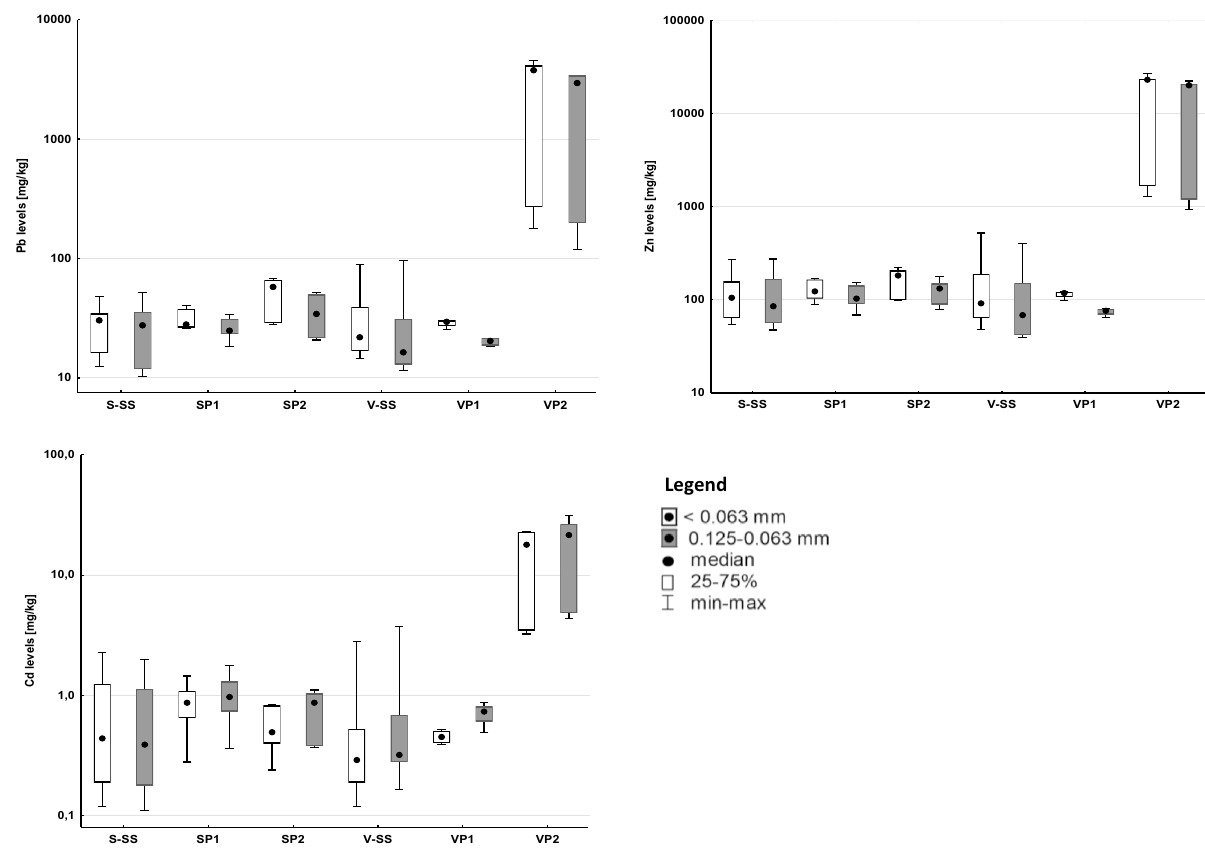
Figure 2. Range, quartiles and median of Pb, Zn and Cd content in Savinja and Voglajna stream sediments and alluvial sediment profiles upstream and downstream main source. S-SS Savinja stream sediments, SP1/ SP2 Savinja river alluvial sediments above/below contaminated site, V-SS Voglajna stream sediments, VP1/VP2 Voglajna river alluvial sediments above/below contaminated